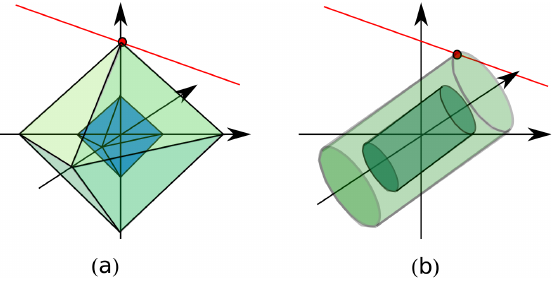
Figure 2. ( a ) Geometrical picture of the (cid:96) 1 minimization; ( b ) Geometrical picture of the trace norm